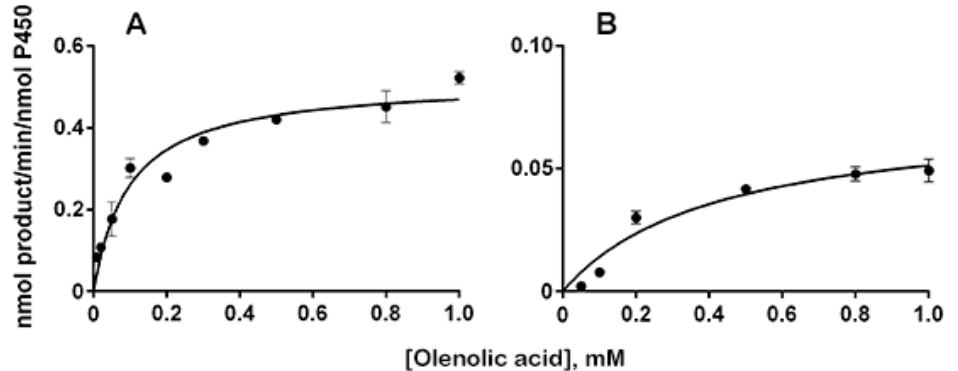
Figure 5. Steady-state kinetics of OA hydroxylation by CYP3A4 ( A ) and HLMs ( B ). The kinetic parameters of HLMs and CYP3A4 were estimated in a potassium phosphate buffer (100 mM, pH 7.4) of 0.25 mL final mixture volume, including an NADPH regeneration system, OA (20 – 1000 µM), and 0.2 µM of CYP3A4 or 0.8 µM of HLMs. The mixtures were incubated at 37 °C for 30 min for CYP3A4 and 60 min for HLMs.